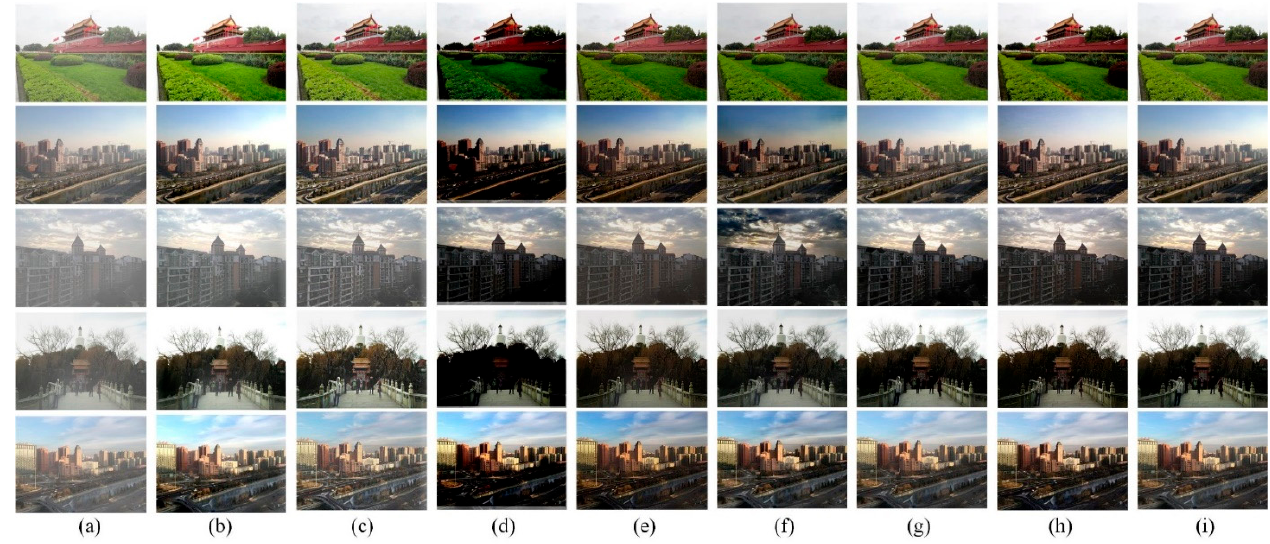
Figure 4. Dehazing results on HSTS dataset. ( a ) Hazy image; ( b ) Fattal’s [26]; ( c ) FVR [43]; ( d ) DehazeNet [32]; ( e ) AOD-Net [15]; ( f ) EPDN [35]; ( g ) AECR-Net [36]; ( h ) TID (ours); ( i ) ground truth.